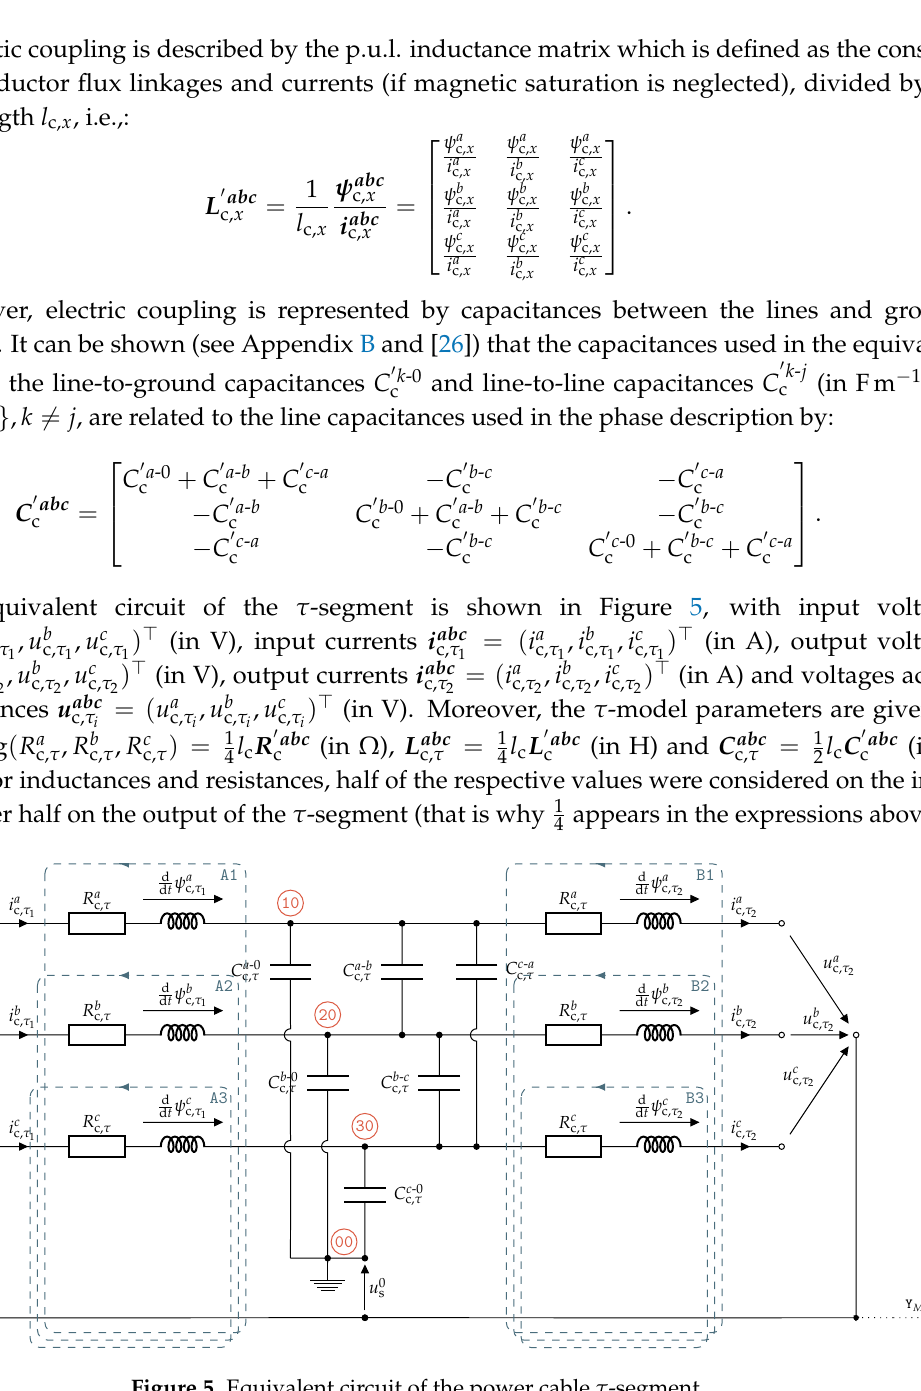
Figure 5. Equivalent circuit of the power cable τ